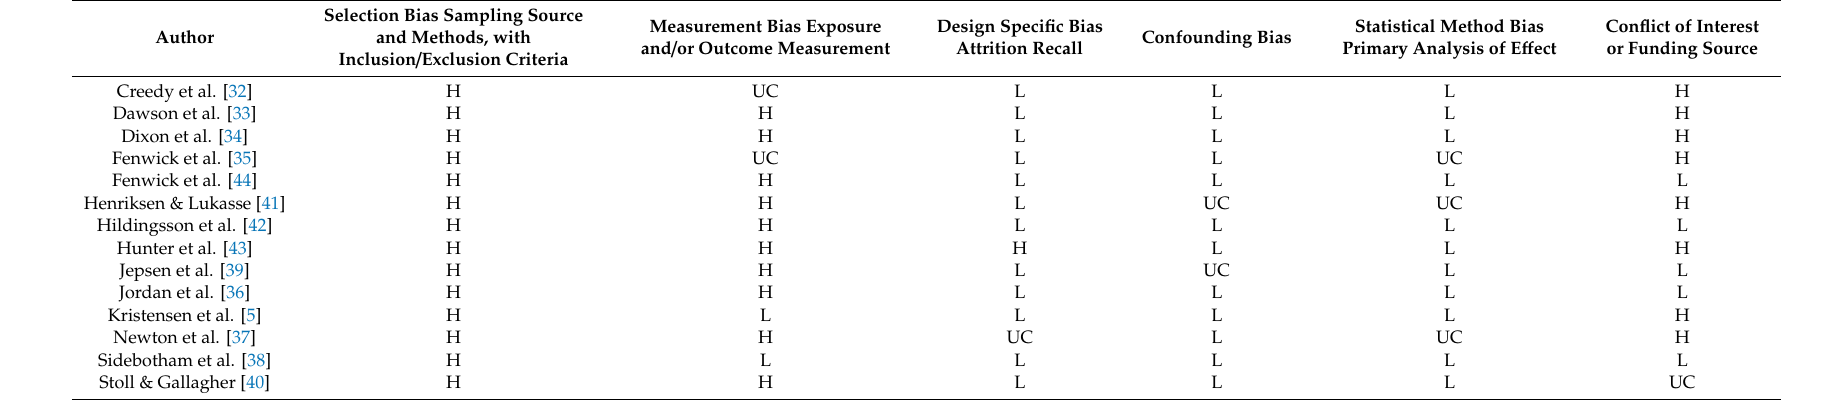
Table 2. Criteria for assessing risk of bias for observational studies by Sanderson et al.